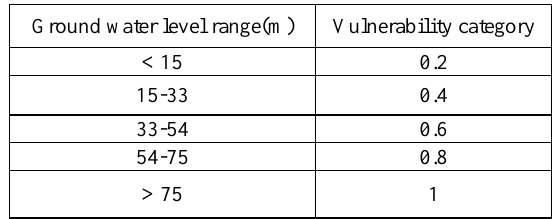
Table 7- Ground Water Level Vulnerability